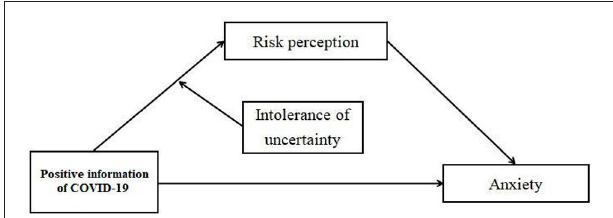
FIGURE 1 | The proposed